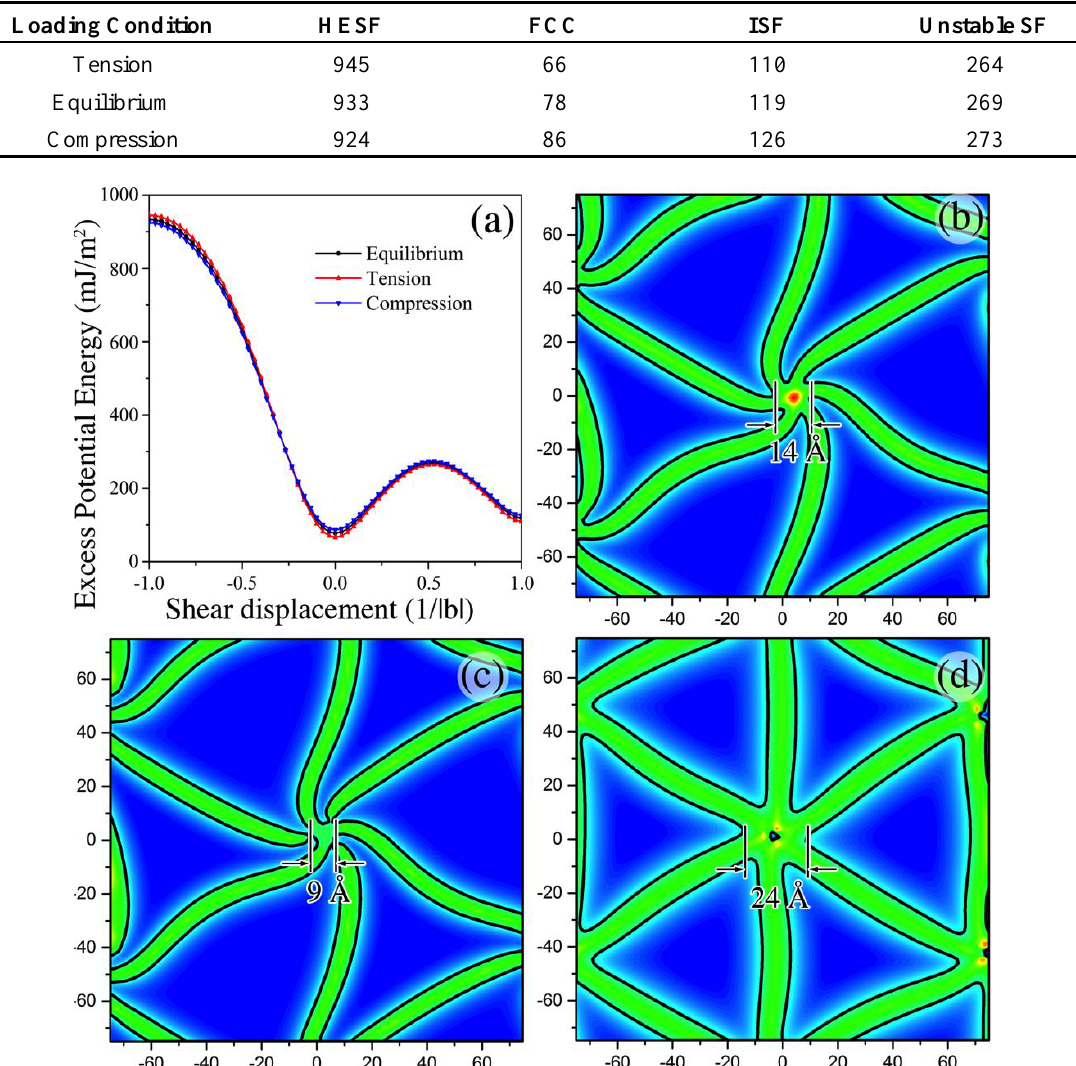
Table 1. Excess potential energy (mJ/m 2 ) for key coherent structures.